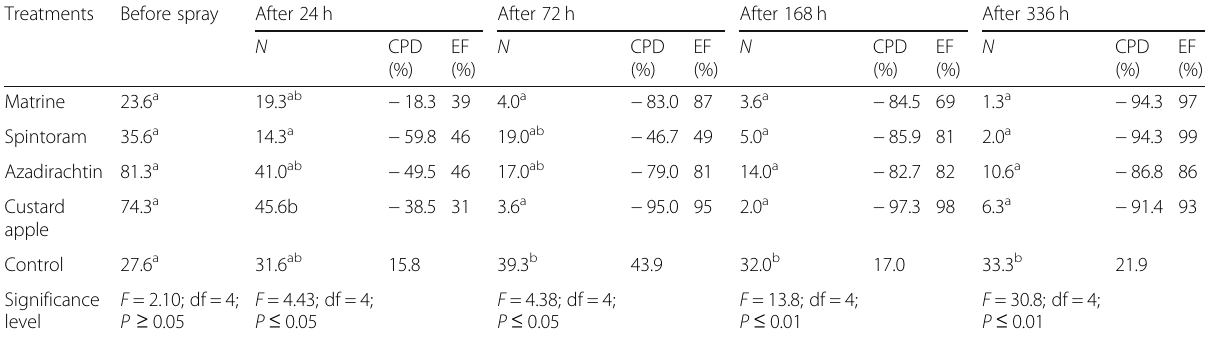
Table 1 Population densities of Aphis gossypii ( N ) on hydroponic cucumber and effectiveness of biopesticides